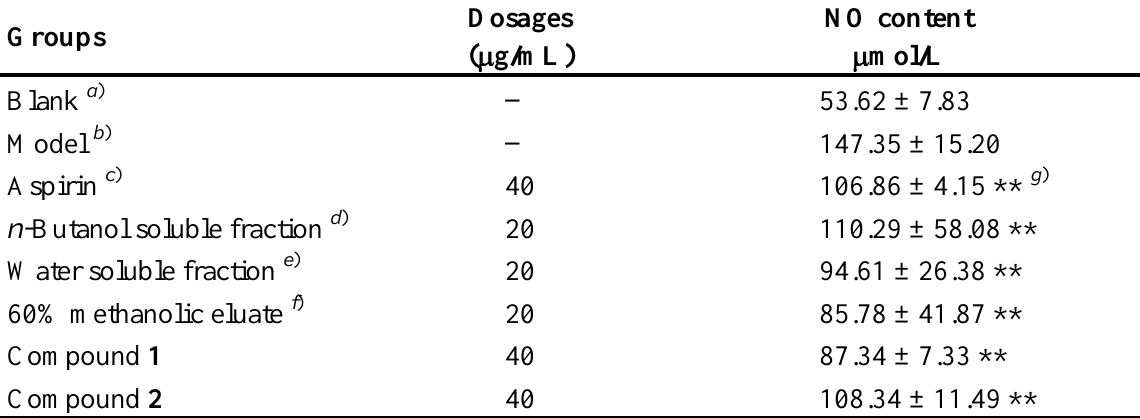
Table 2. The inhibitory effects of extracts and compounds 1 and 2 on NO production ( ± S , n =